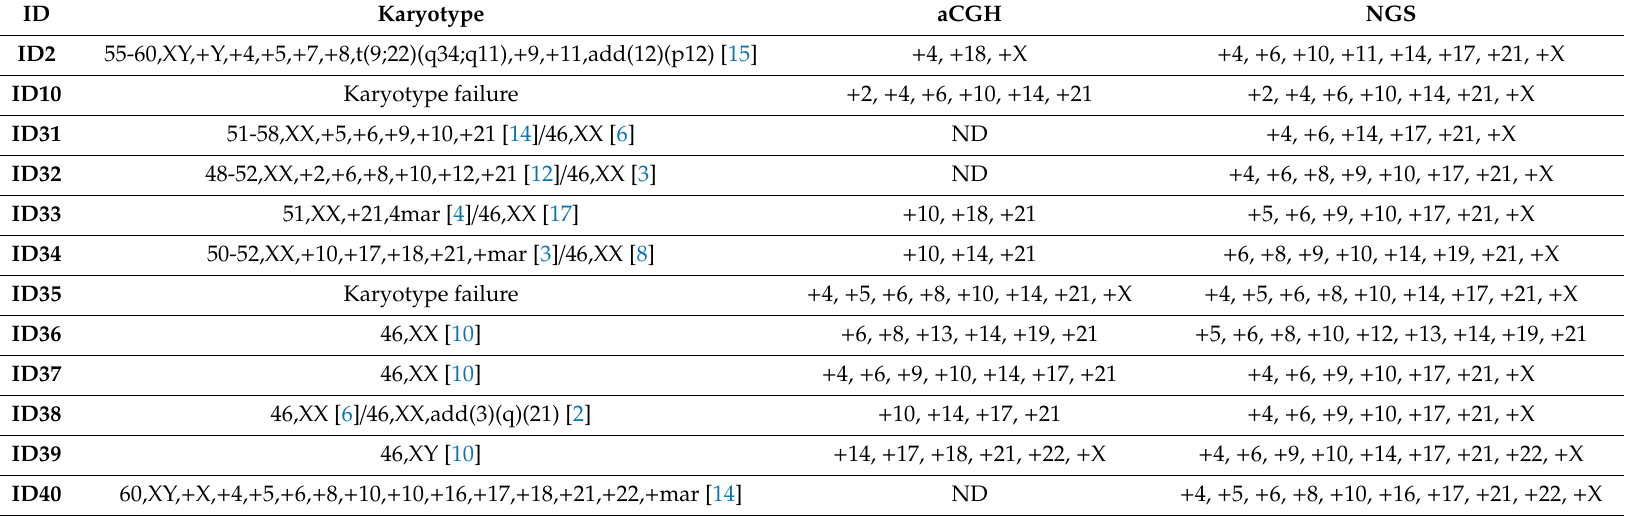
Table 2. High hyperdiploid cases detected by the custom NGS panel. Twelve cases (listed by ID in bold) with high hyperdiploid clone detected by next-generation sequencing (NGS), with their corresponding karyotype and fluorescent in situ hybridization (FISH), microarray-based comparative genomic hybridization (aCGH), and custom NGS panel results are